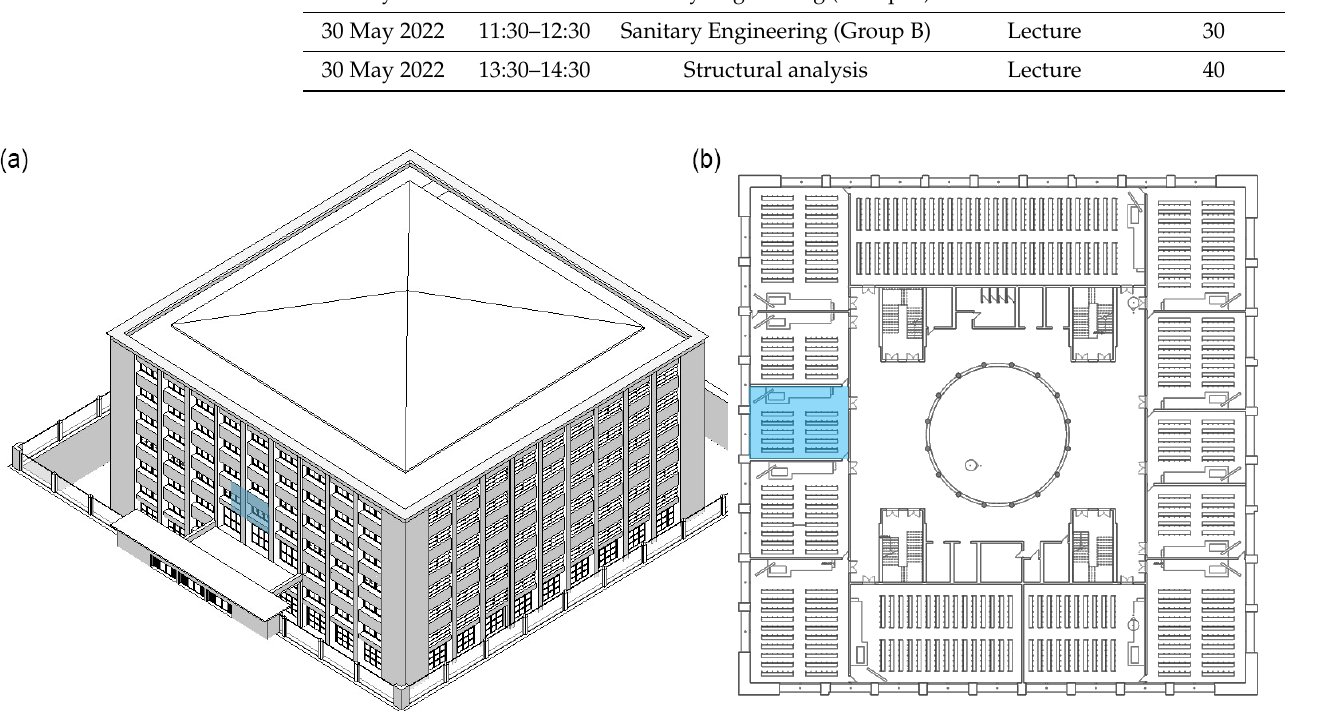
Table 7. Mean values of indoor environmental